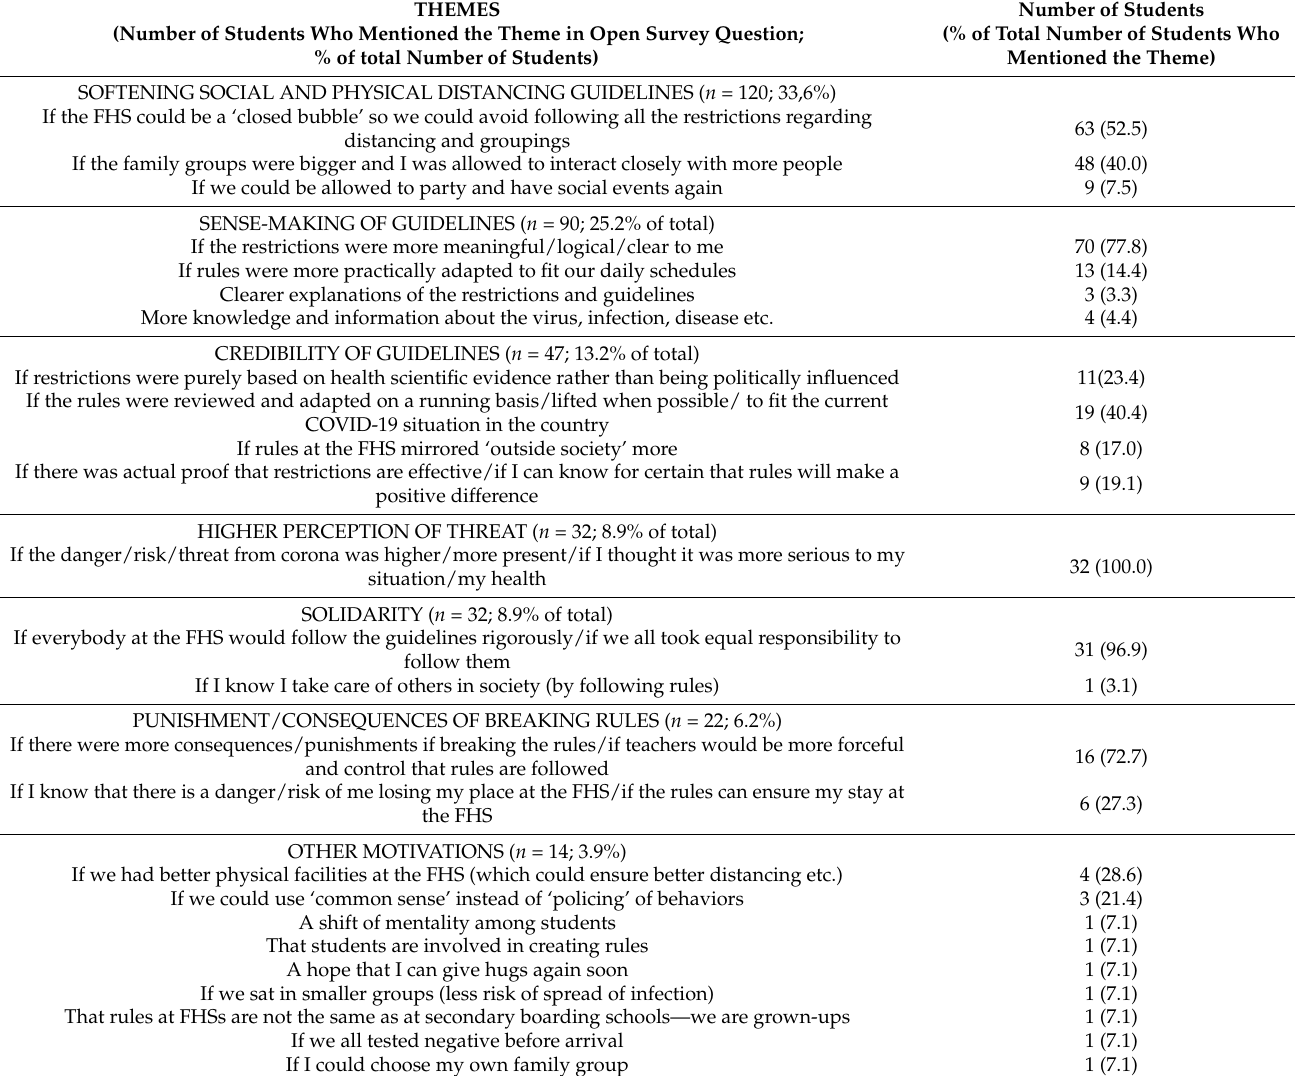
Table 1. Students’ answers to open survey question: ‘What could motivate you to follow the COVID- 19 guidelines even better?’ ( n =